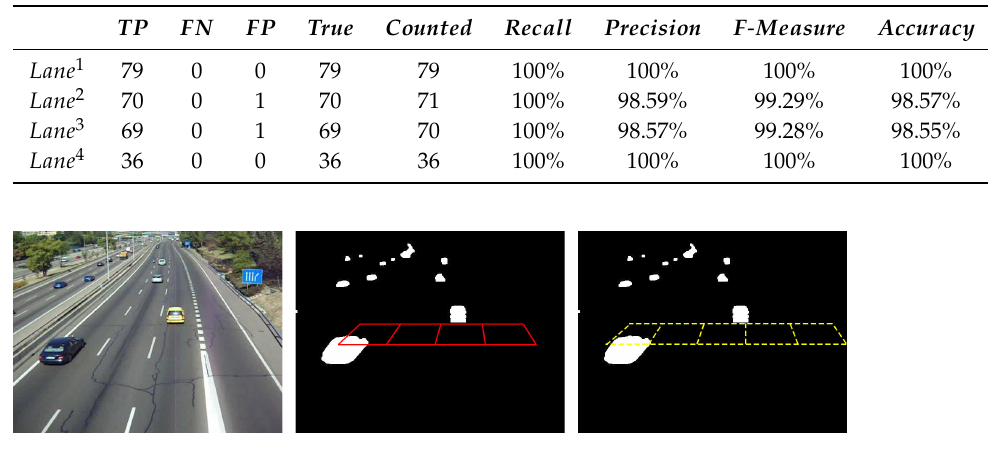
Figure 15. Example of the experimental results in Video I. Table 10. Experimental results of Video